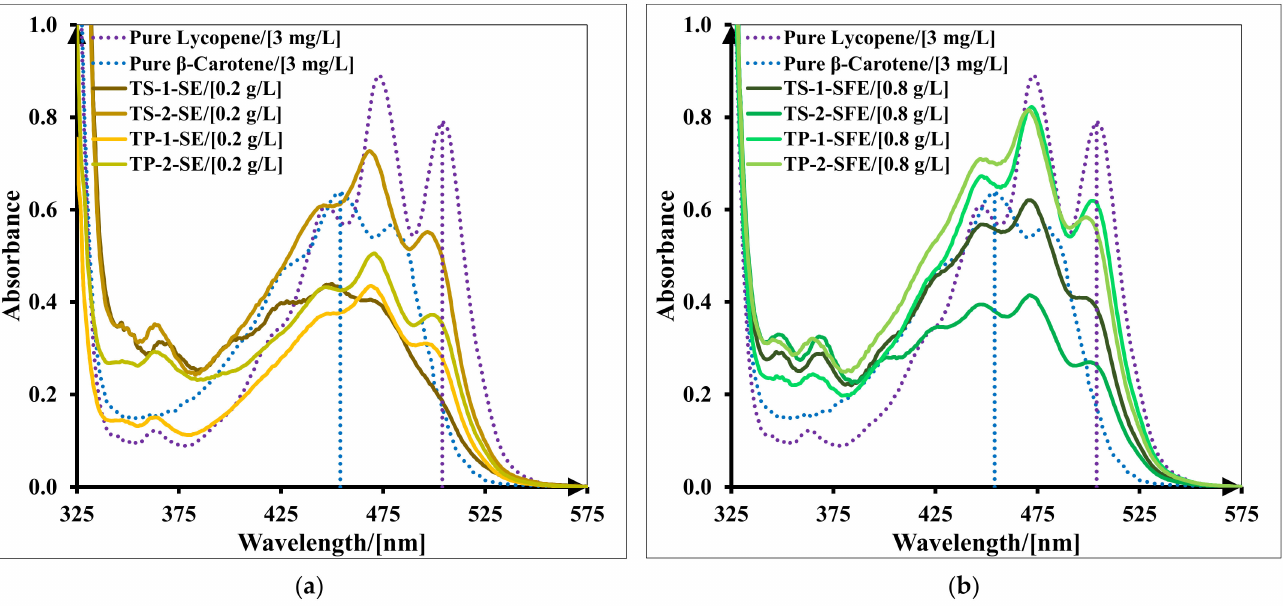
Figure 4. UV–VIS spectra of tomato raw extracts: ( a ) SE raw extracts obtained from tomato slices (TS) and tomato pomace (TP), using as extraction solvents (1) bioethanol and (2) ethyl acetate; ( b ) SFE raw extracts obtained from tomato slices (TS) and tomato pomace (TP), using as operating parameters set (1) at 400 bar, 70 ◦ C, 9 kg/h and set (2) at 450 bar, 70 ◦ C, 11